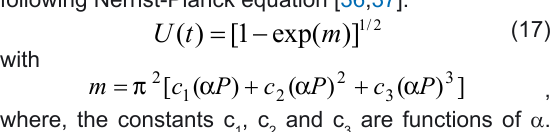
Table 5. Theoretical q vs. t curves (dashed curves) are t also compared to experimental points in Fig. 5a and 5b.